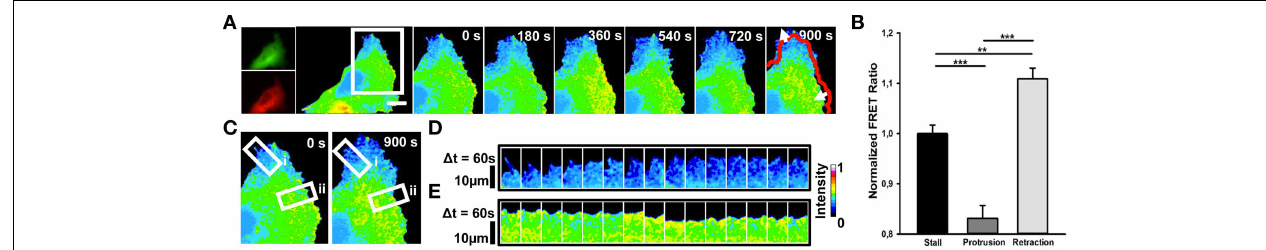
along the cell edge from RhoA neuroblastoma cells from two experiments. ** p < 0 . 01 , *** p < 0 . 001 using ANOVA test ( C – E ) Montage images showing the dynamics of RhoA activation in protruding (D) and retracting sections (E) along the cell edge. (C) Images showing the regions of interest selected for the montage (white boxes) (i, protruding region; ii, retracting region). (D,E) Montage images highlighting a low RhoA activity in protruding regions (D) and a higher RhoA activity in retracting ones (E) . Intensity scale on the right in (D) applies to (A,C–E)